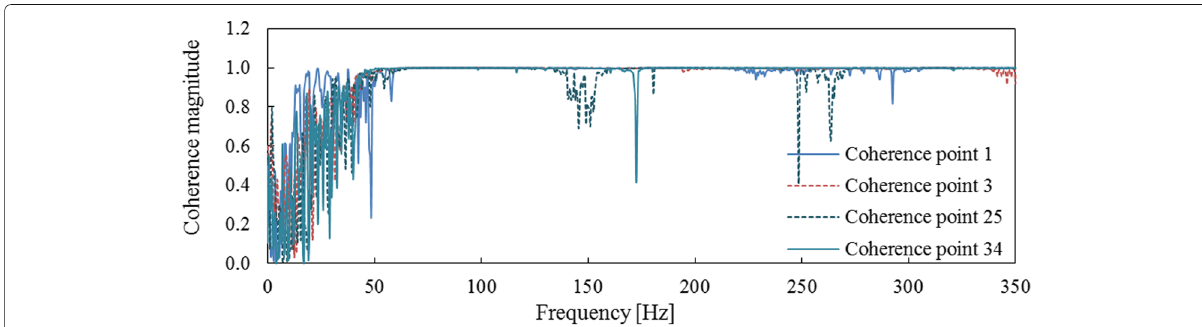
Fig. 15 Coherence plots of sound pressure and response velocity for four measurements located on the membrane